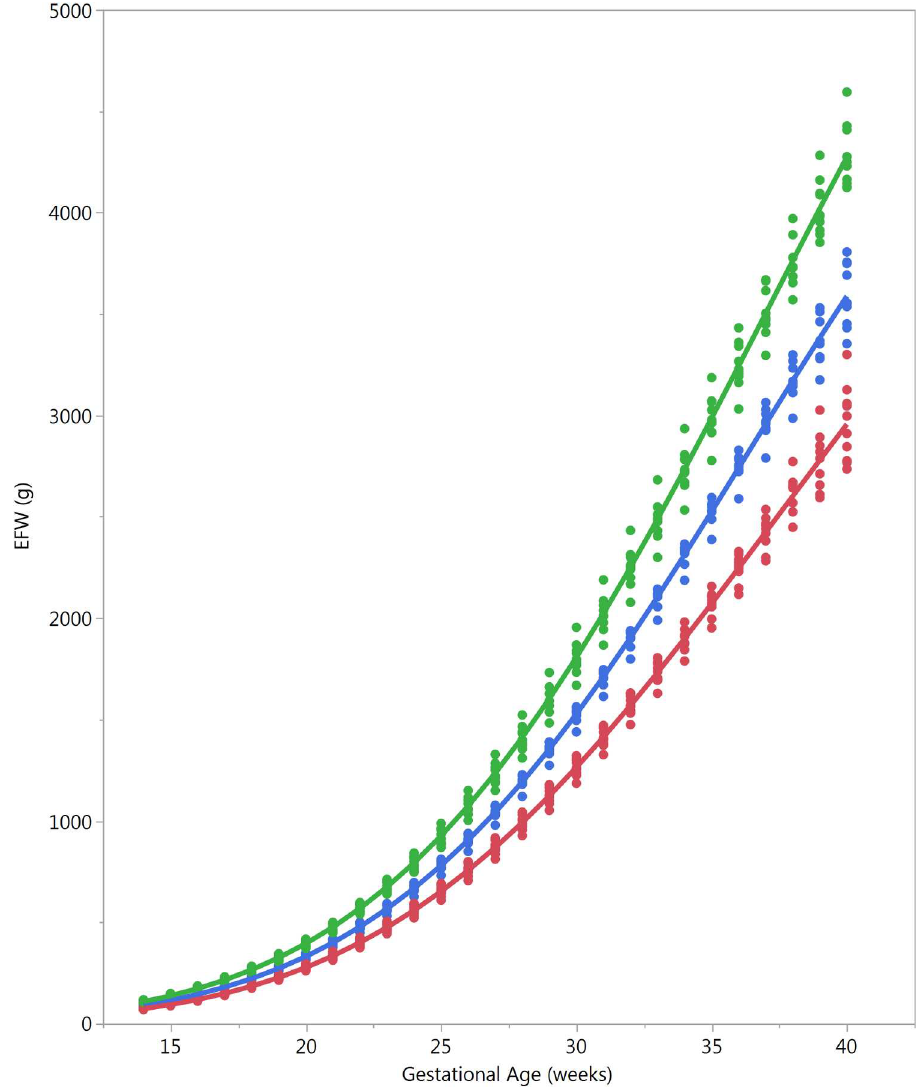
Fig 5. Country differences in estimated fetal weight. Selected percentiles for estimated fetal weight (EFW) for the ten participatingcountries, showingthe magnitude of differences (red, 5th percentile; blue, 50th percentile; green, 95th percentile; each dot denotesa